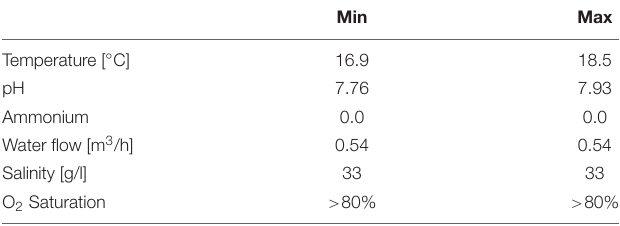
TABLE 3 | Water/environmental conditions.